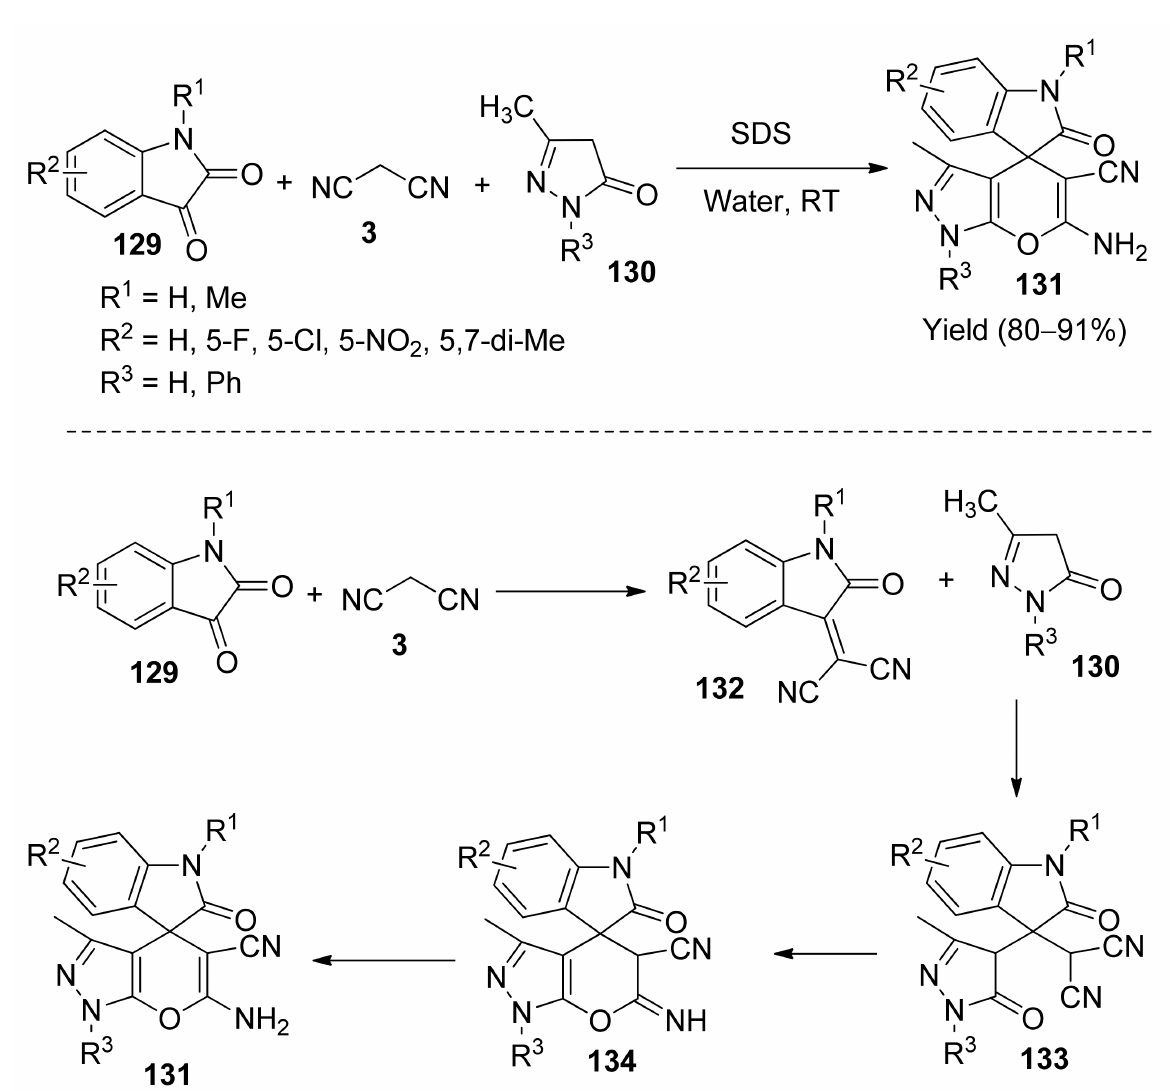
Farokhian and co-workers [96] developed an efficient and novel sulfonic acid-functionalised ionic liquid [DMBSI]HSO 4 catalyst for the one-pot synthesis of pyrano[2,3- c ]-pyrazoles with higher yields (85–95%) ( 137 ) in a short reaction time (20 min) at 90 ◦ C (Scheme 38). The four-component condensation reaction was implemented with dimethyl malonate ( 136 ), ethyl acetoacetate ( 12 ), aromatic aldehyde ( 135 ), hydrazine hydrate ( 11 ) and [DMBSI]HSO 4 (0.18 mmol) under solvent-free conditions. The plausible mechanism then proceeded to the resulting tandem reactions—Knoevenagel condensation, Michael addition and cyclisation in sequence—to obtain the target